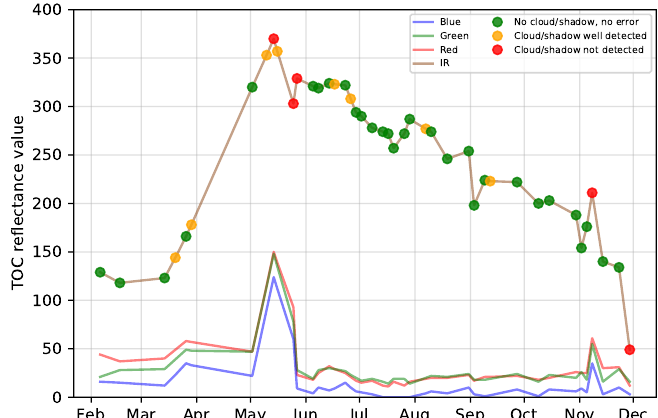
Figure 12. Influence of undetected clouds in the time series, an example with the reflectance evolution of a Oak tree pixel in 2006. If the dot is red in the infrared time series, it means the pixel is in a cloud or in a shadow but this was not detected by the algorithm. So this pixel is taken as a valid pixel to be used to gap-fill nearest missing